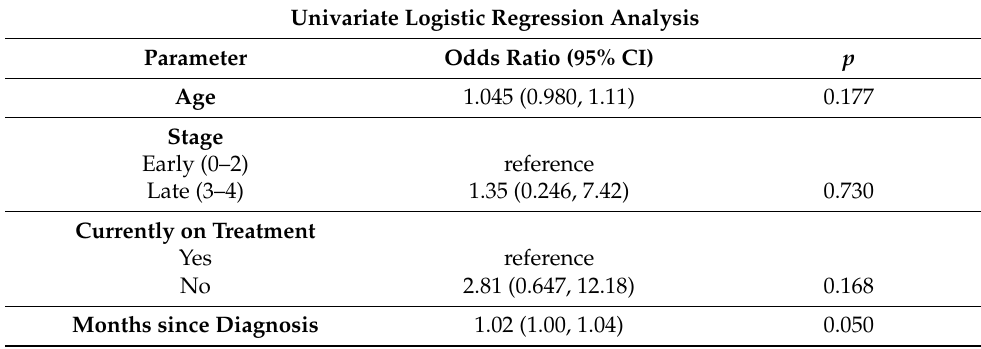
Table 3. Binomial logistic regression examining variables associated with endorsing survivor